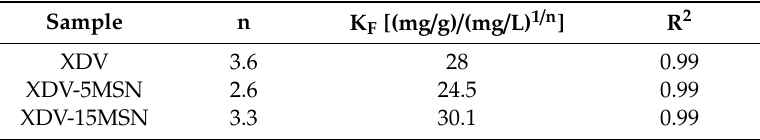
Figure 4. RB equilibrium adsorption ( a , Freundlich fitting curves are dotted) and the adsorbed dye percentage ( b ) of XDV and XDV-xMSN. Table 2. Freundlich parameters of XDV, XDV-5MSN and XDV‐15MSN.